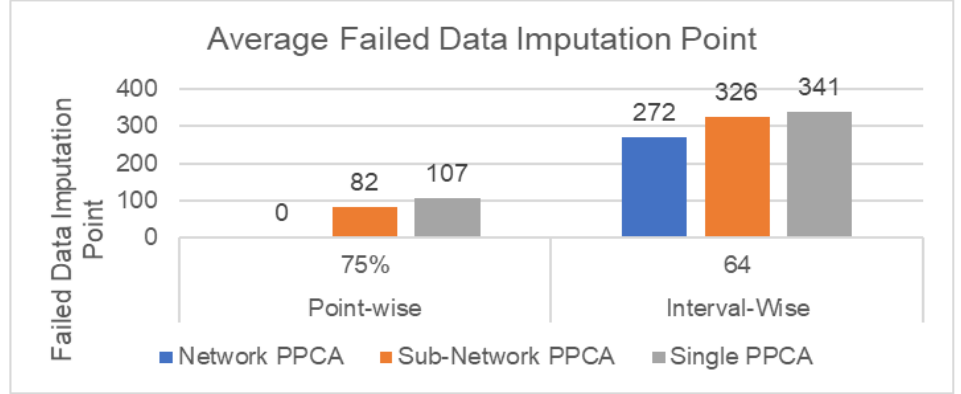
Figure 8. Average failed data imputation points for Network PPCA , Sub-Network PPCA , and Single PPCA for Scenario A with 75% ratio of point-wise missing data and 64 intervals of interval-wise missing data.